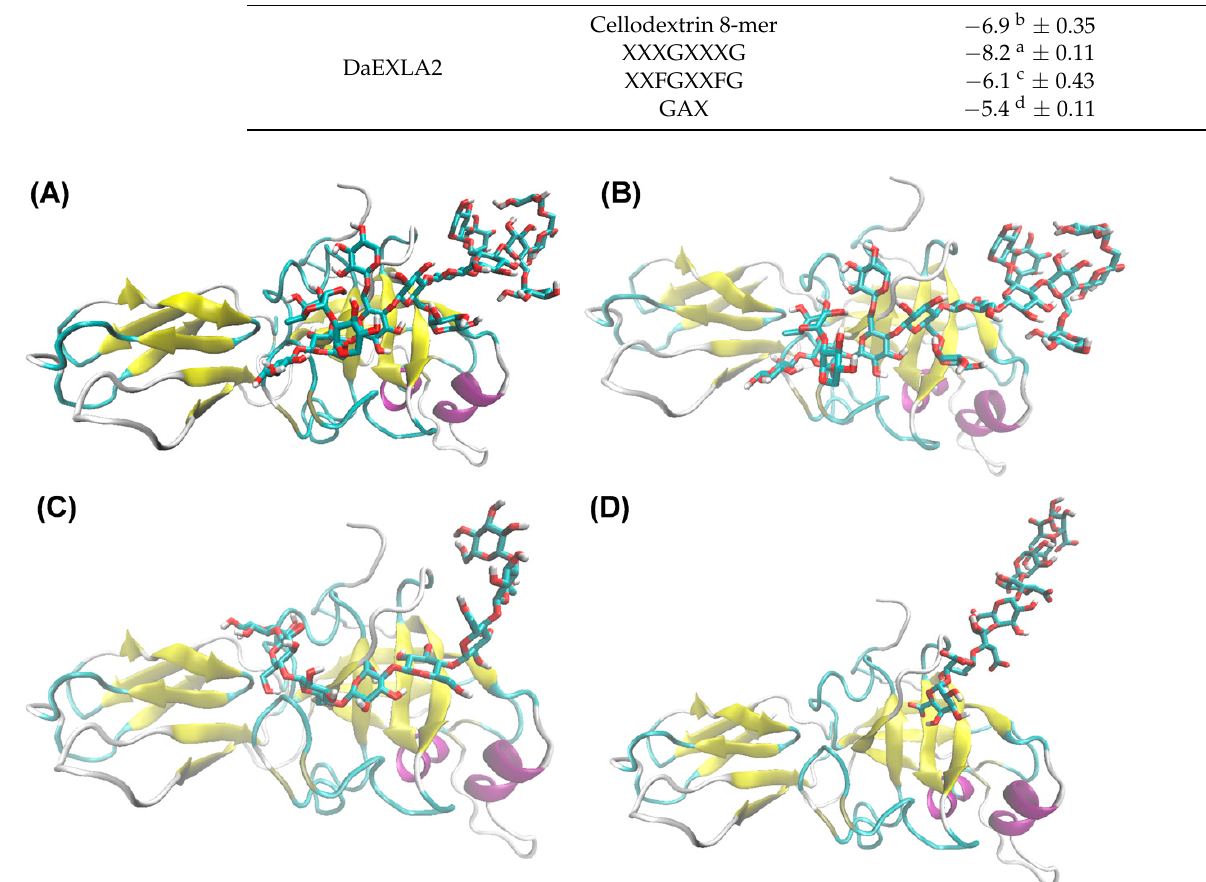
Figure 6. Protein–ligand interaction mode of DaEXLA2 with XXXGXXXG ( A ), XXFGXXFG ( B ), Cellodextrin 8-mer ( C ), and GAX ( D ).